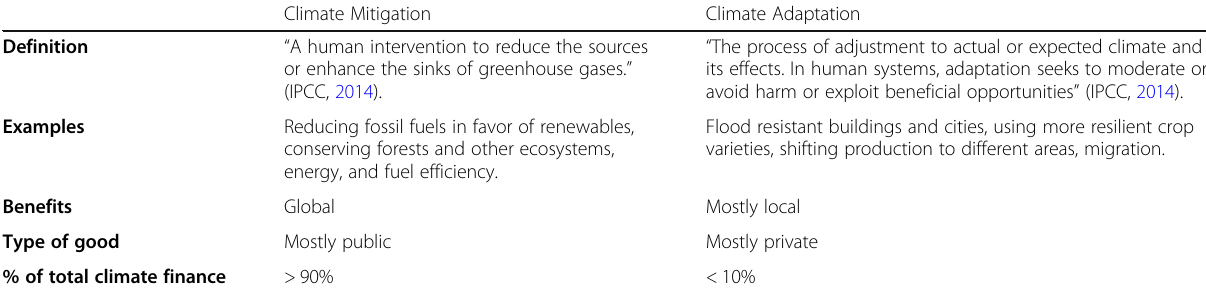
Table 1 Definitions of and differences between climate adaptation and